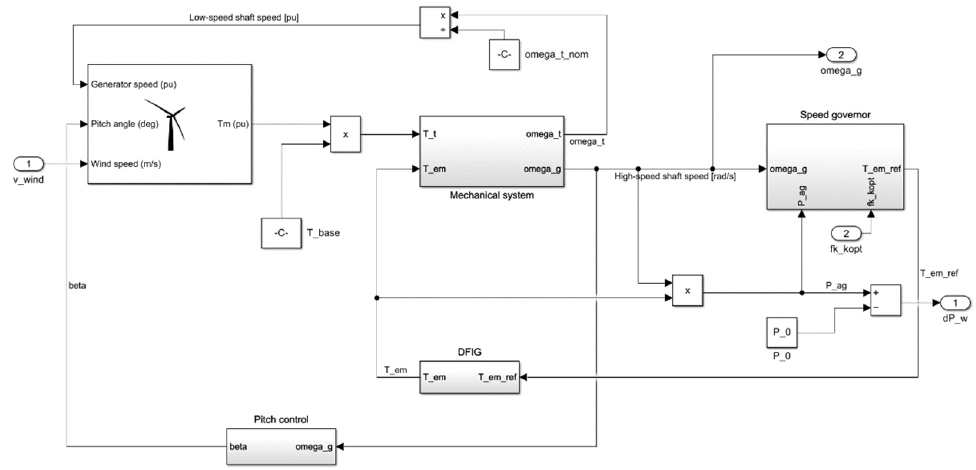
Figure 8. Block diagram of a VSWT model.